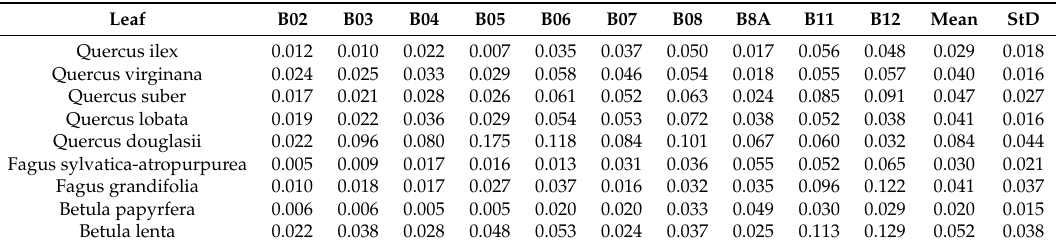
Table 3. Root Mean Square Error (RMSE) of the simulated reflectance to the Sentinel-2 BOA reflectance per band and its mean and Standard Deviation (StD). Simulations using Betula papyrfera had the smallest RMSE (Mean RMSE is 0.20) and Quercus douglasii had the largest one (Mean RMSE is 0.84). Leaf B02 B03 B04